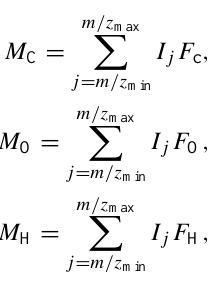
est NO + ion time-of-flight traces are observed from NaNO 3